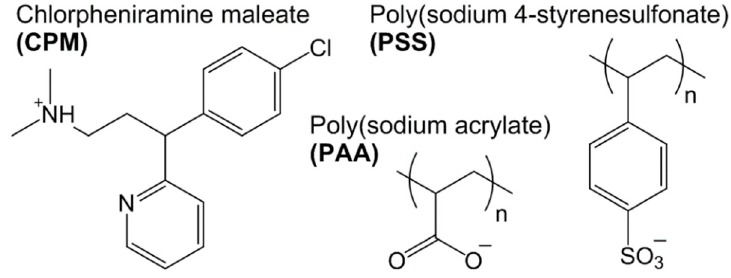
Figure 3. Molecular structure of CPM, PAA, and PSS.